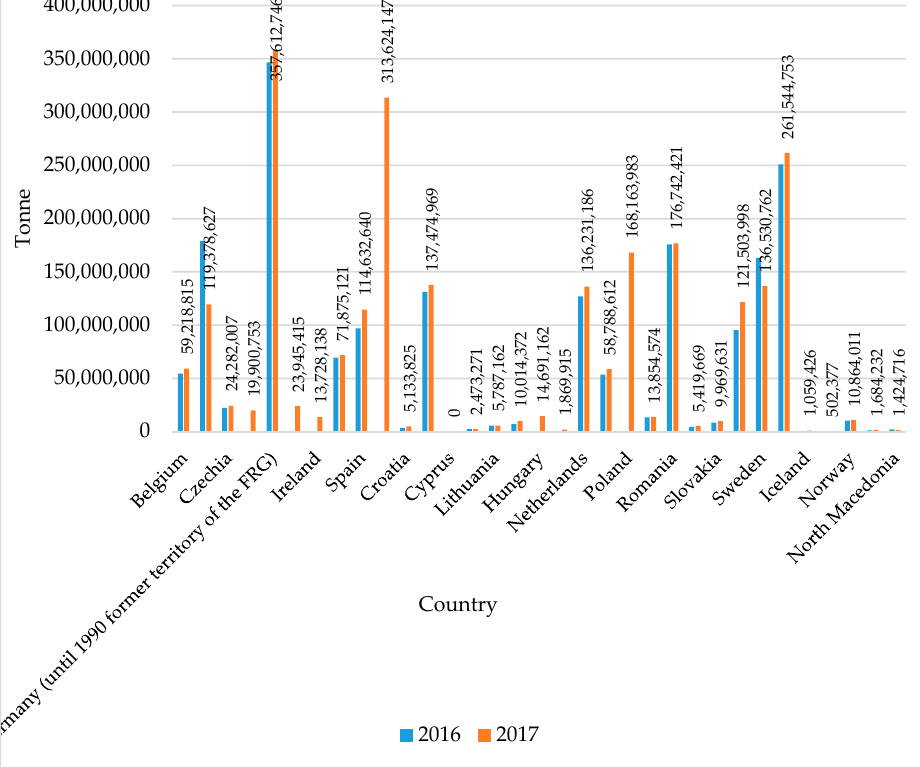
Figure 3. Amount of waste generated in the European Union (EU) for 2016–2017 (tons) [45]. Of the total amount of waste, at the EU level, 253,440,000 tons in 2016 and 258,890,000 tons in